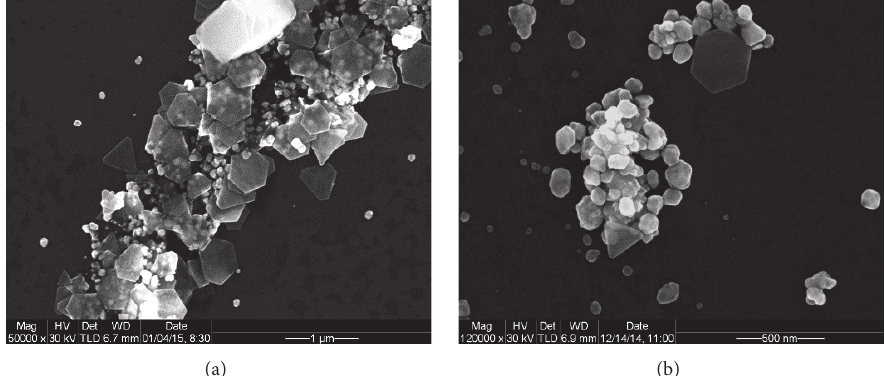
Figure 2: SEM images showing results from gold nanoparticle synthesis with variances in mixing parameters. (a) Vigorous mixing at around 250 rpm and (b) gentle mixing on a platform